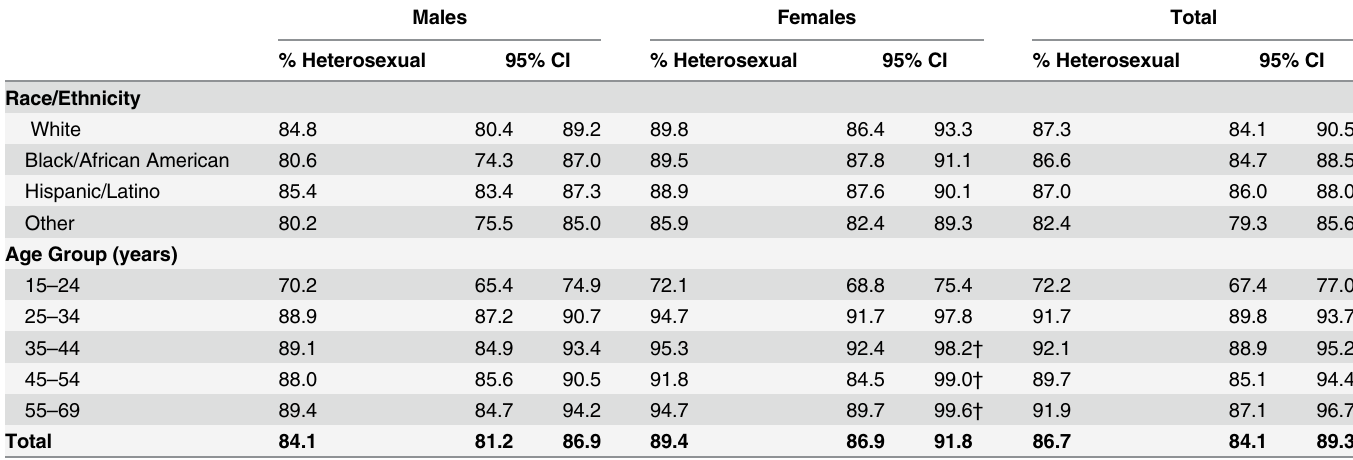
Table 3. Estimated proportion of heterosexual persons in the United States, by sex, race/ethnicity, and age group – meta-analysis of 3 national sur- veys * . CI = confidence interval.